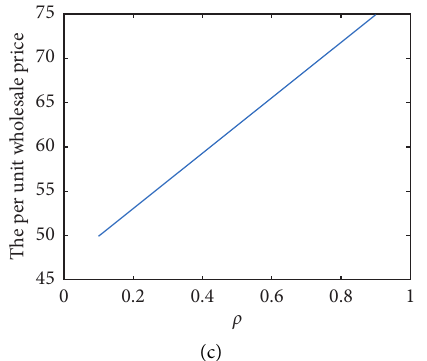
Figure 4: The effect of the degree of consumer preference for the retail channel ρ on prices based on decentralized decision.